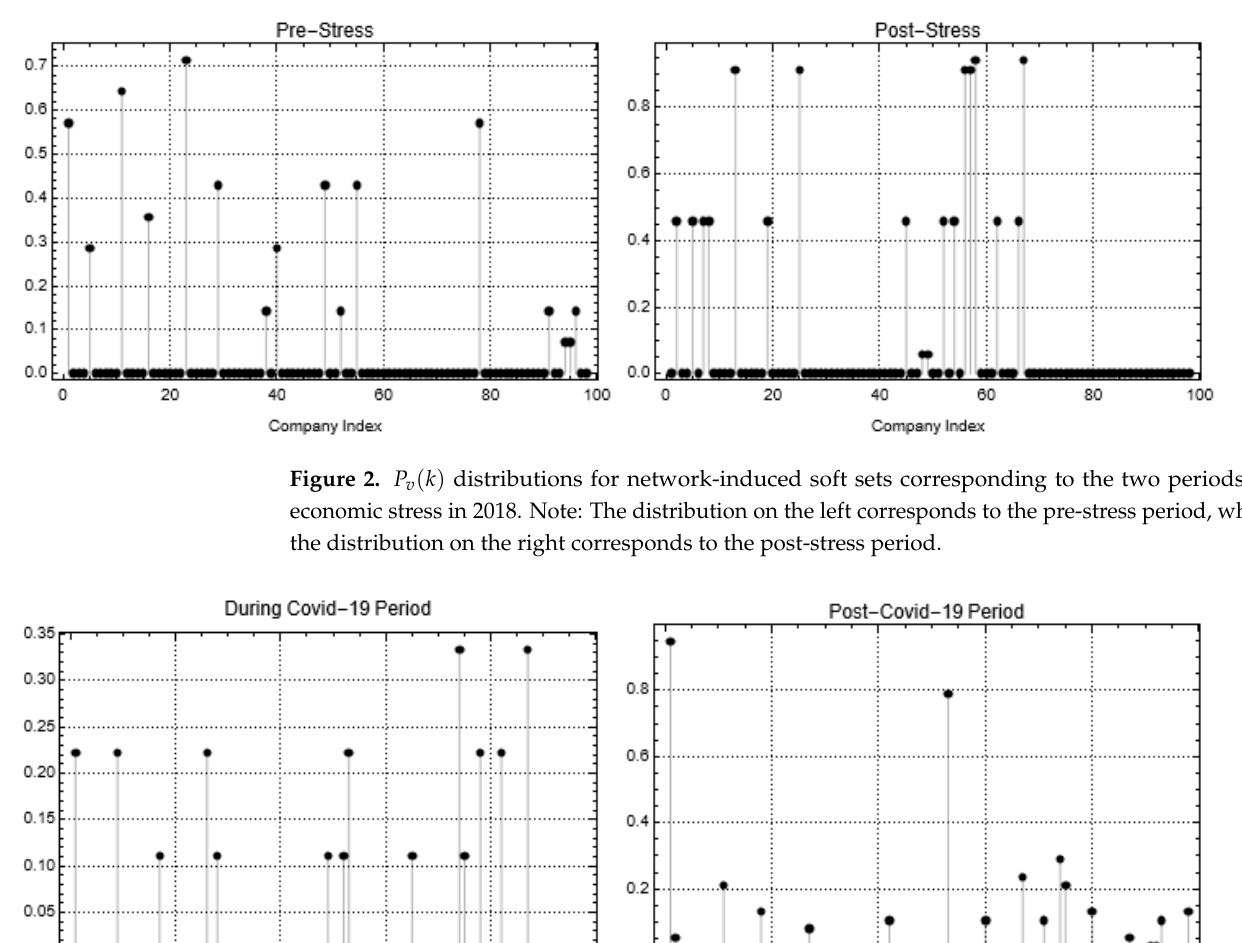
Figure 4. Directed network (on the left) and a network soft set (on the right) representation for the 2018 pre-stress economic period. Note: Numbers denote company indices (see Tables A1 and A2) and 𝐸 = {𝑒 (cid:2869) , 𝑒 (cid:2870) , … , 𝑒 (cid:2869)(cid:2872) } is the soft parameter set.